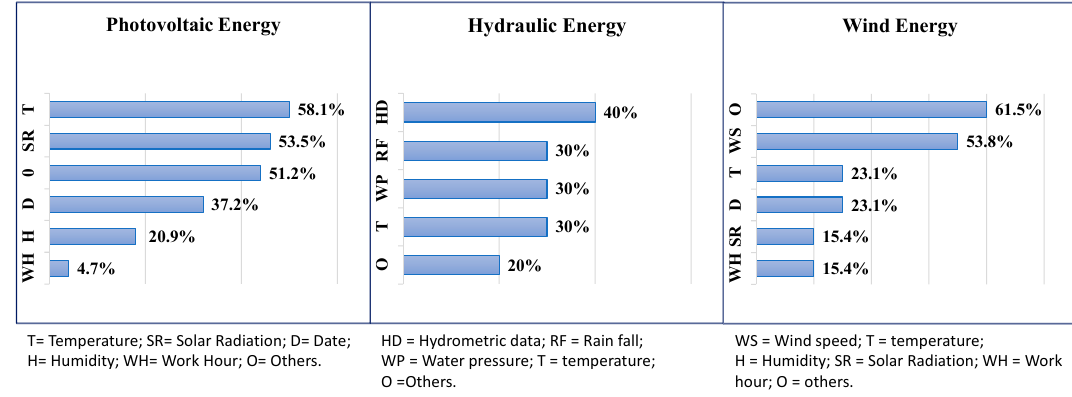
Figure 2. Most used parameters in the Renewal Energy field.